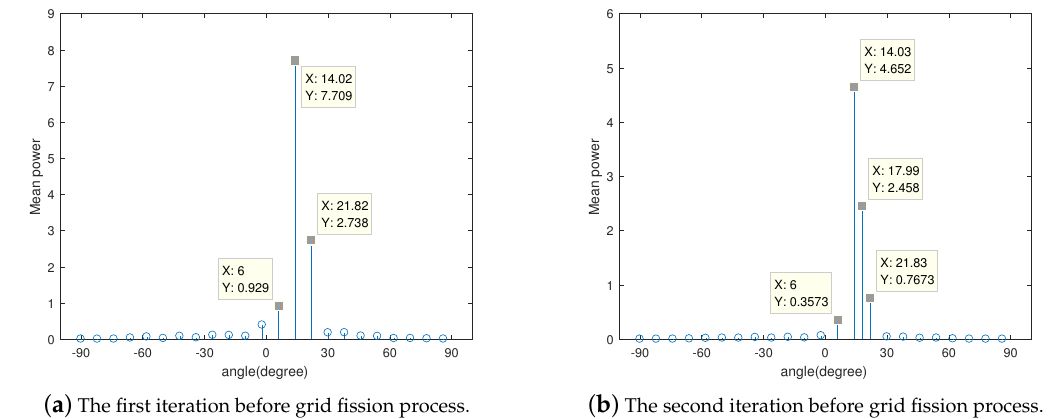
Figure 3. The spatial spectrum at the first and second iteration in the initial estimation. Sources are from 14 ◦ and 17 ◦ with SNR = 10